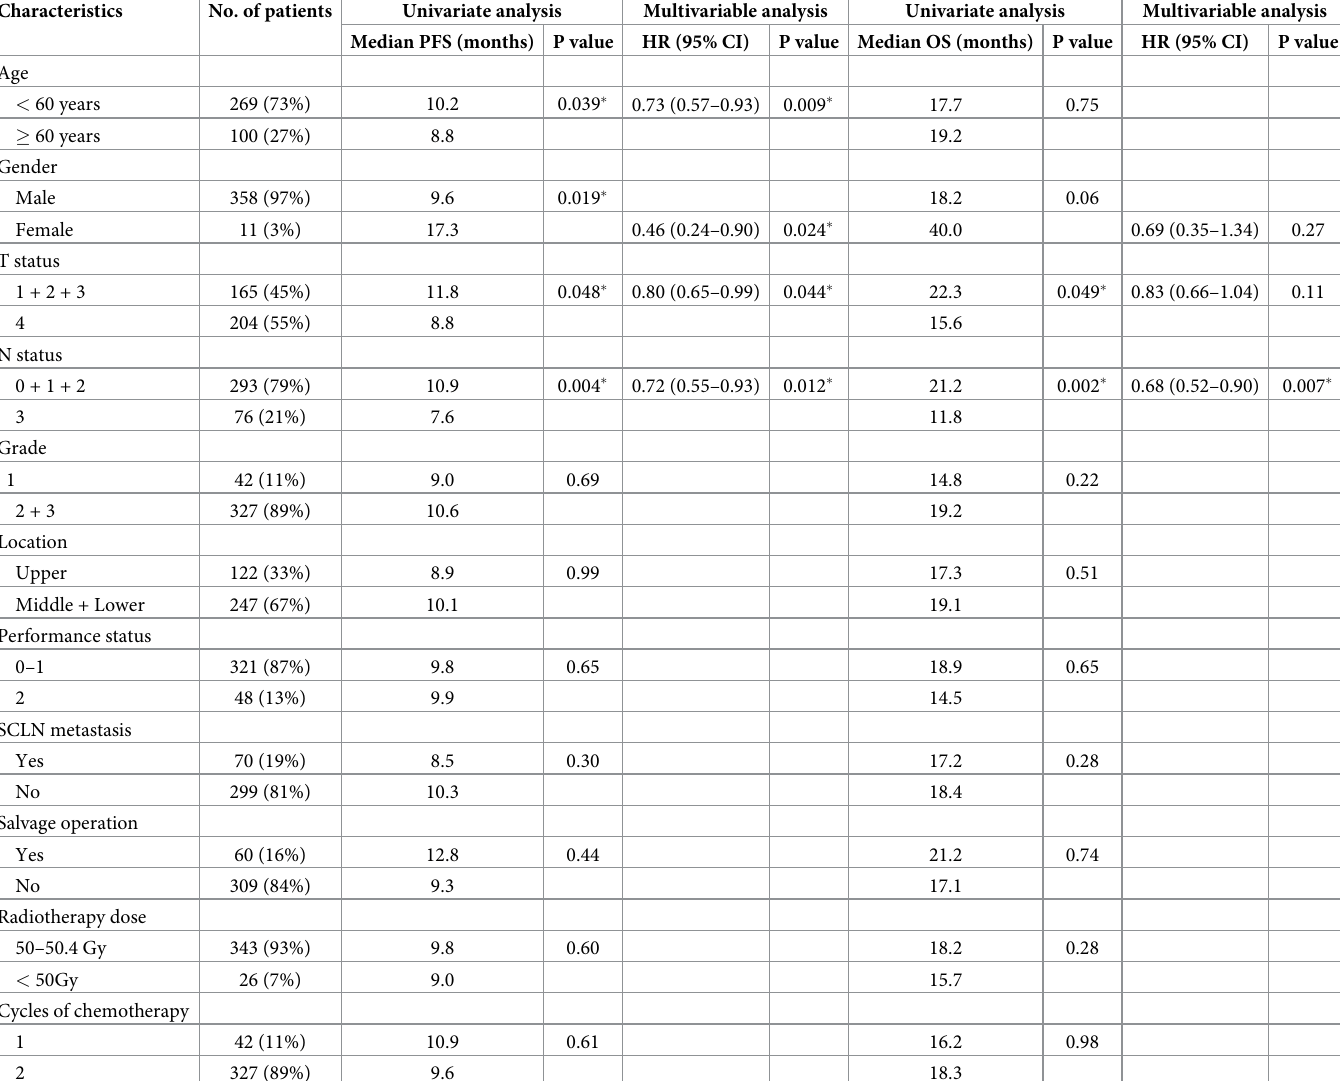
Table 2. Univariate and multivariate analyses results of PFS and OS in in 369 locally advanced esophageal squamous cell carcinoma patients receiving curative CCRT.